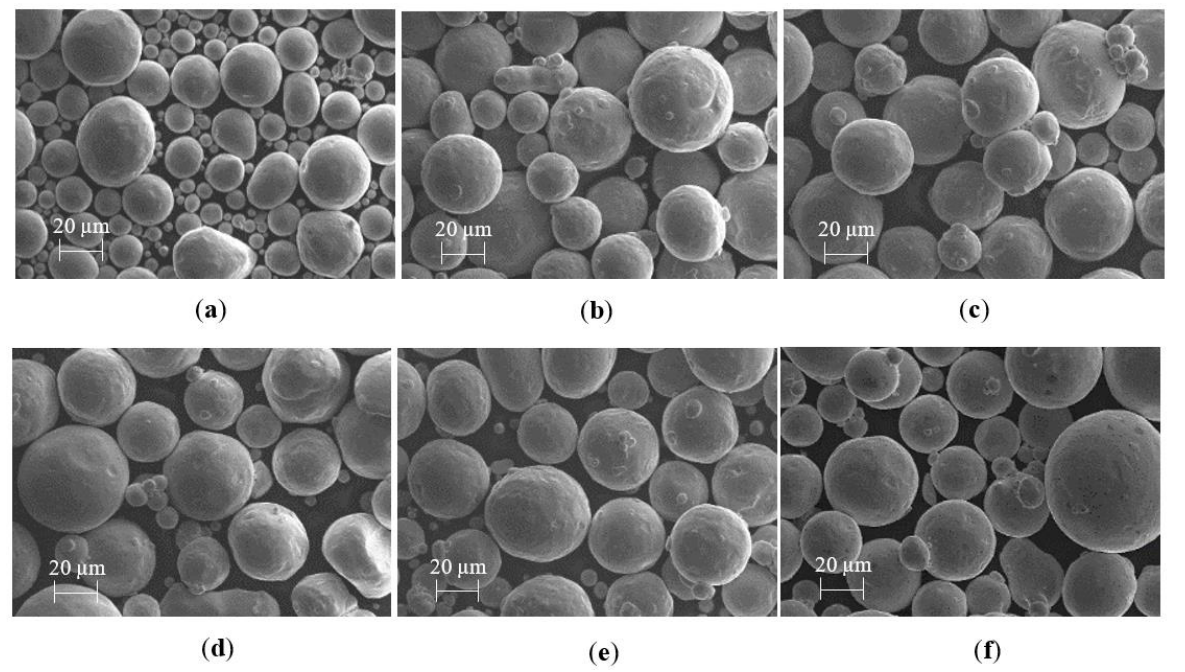
Figure 2. Scanning Electron Microscopy (SEM) data showing particle morphology for ( a ) Carpenter